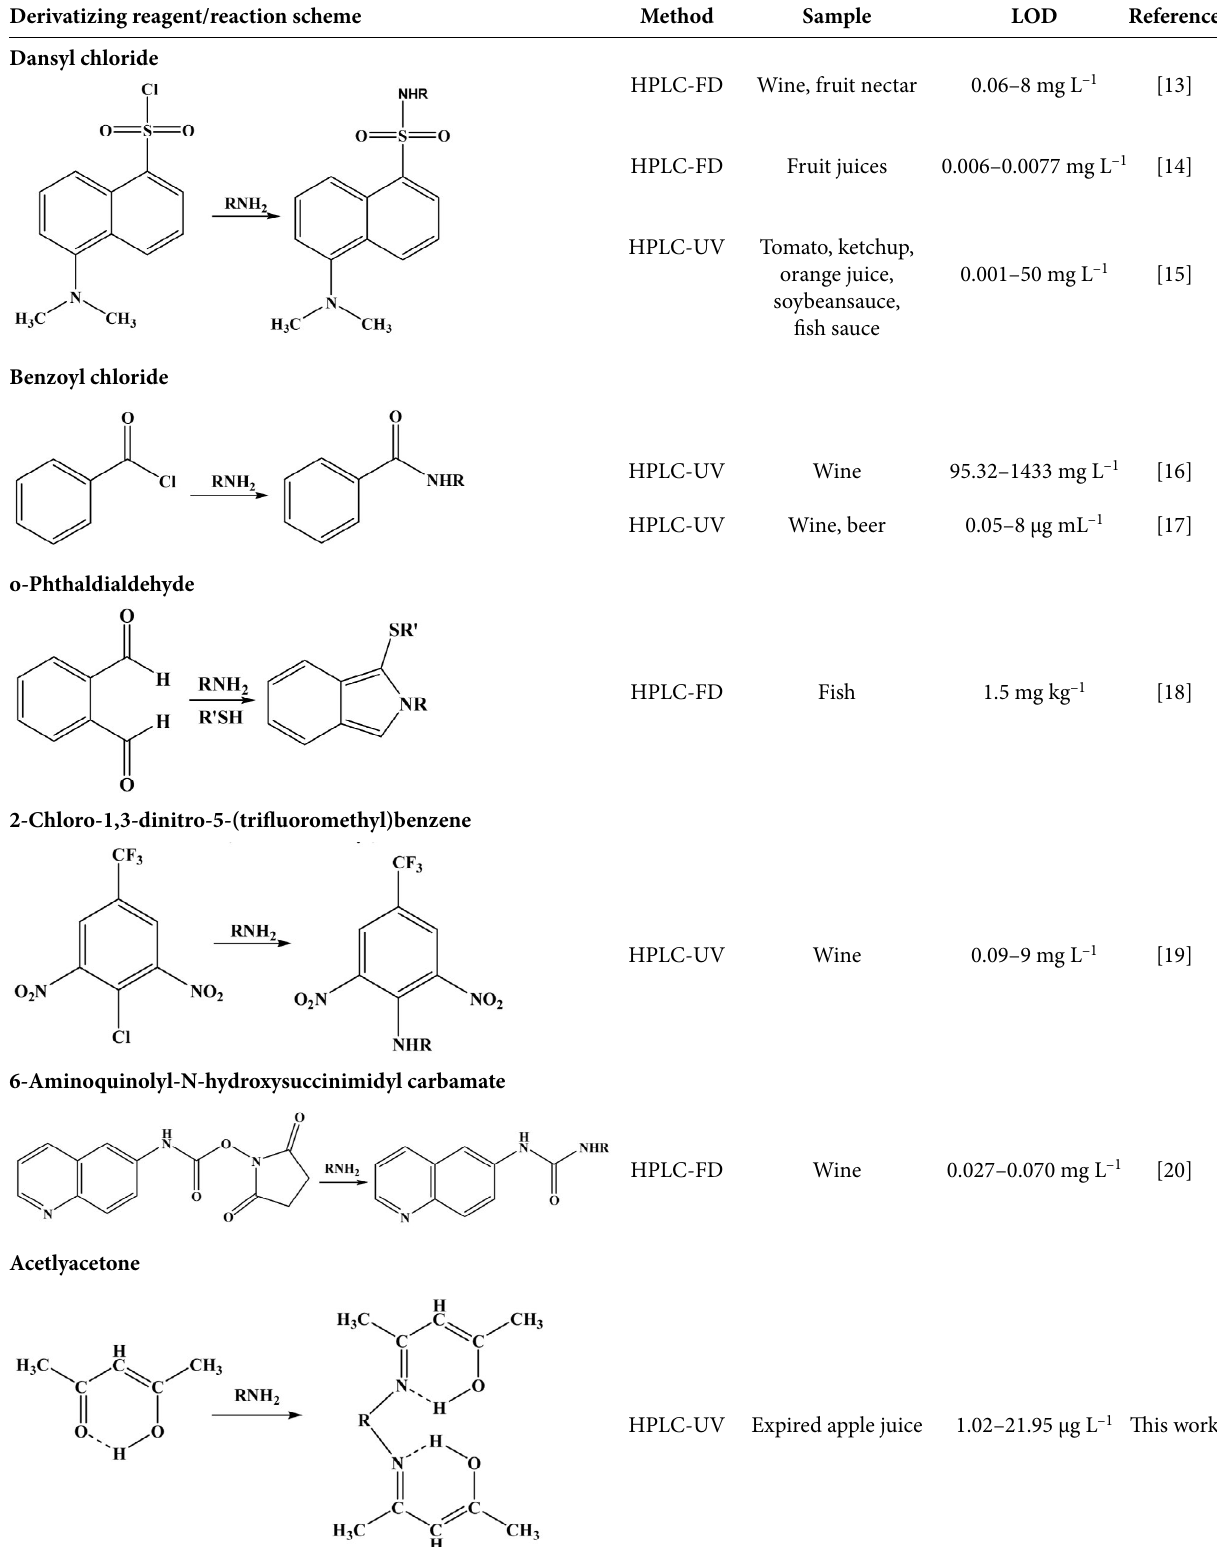
Table 5. Comparison of literature HPLC methods ( published over the period 2009–2017) for biogenic amines involving the derivatization with principle reagents. Derivatizing reagent/reaction